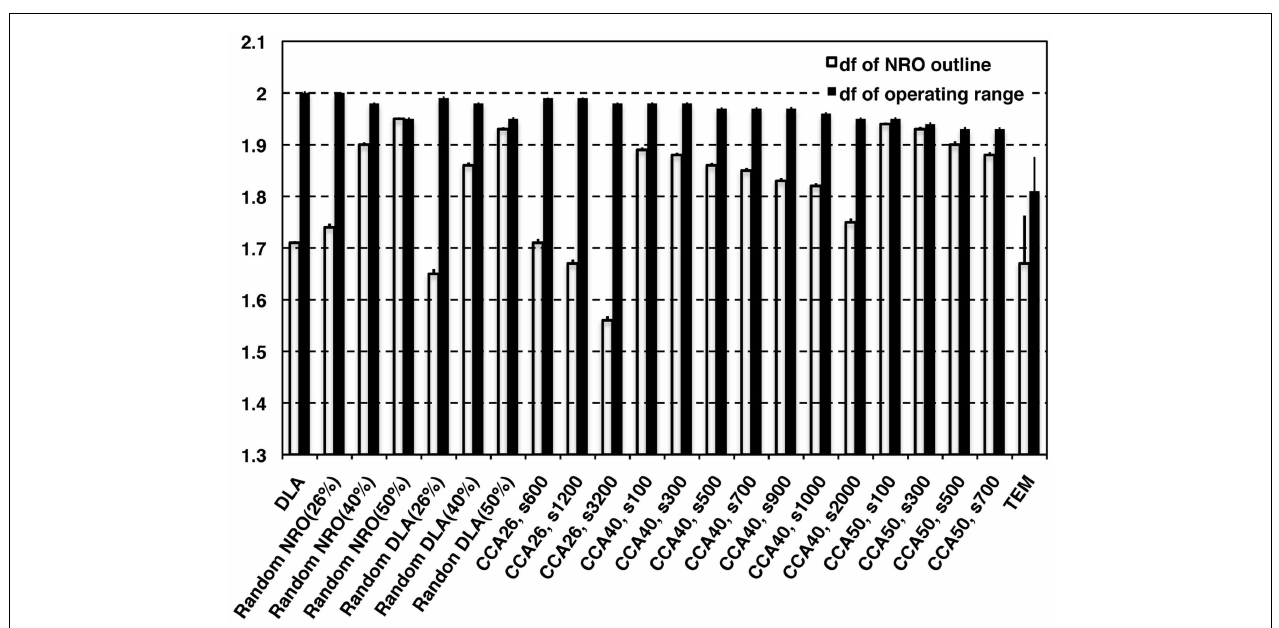
FIGURE 2 | Fractal dimensions of physiological environment and simulated models. White bars represent the d f values of outline of NRO in models. Black bars represent the d f values of the operating range for a mobile particle in the